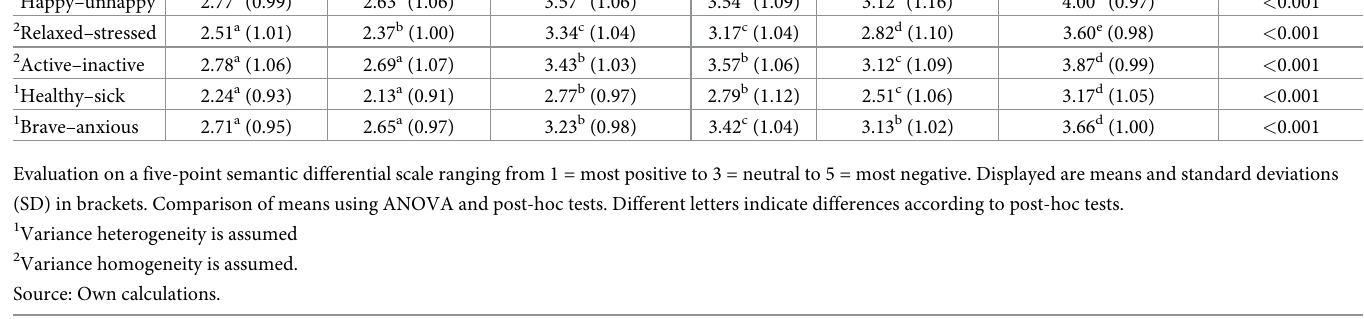
The evaluations of the pens (Table 5) reveal that in terms of species-appropriateness and naturalness the three pictures showing the straw pen are evaluated equally and the three pic- tures showing the slatted floor pen are evaluated equally as well. The straw pen receives more positive values compared to the slatted floor pen on all pictures. Looking at how comfortable the pens are rated by participants, the most positive evaluation is given to the straw pen with the ‘happy’ pig, followed by the other two straw pens (separately and with the ‘unhappy’ pig). Again here, the slatted floor pen is evaluated always the same and more negatively. The straw pen with the ‘happy’ pig is evaluated as the most future-proof and the cleanest pen (same